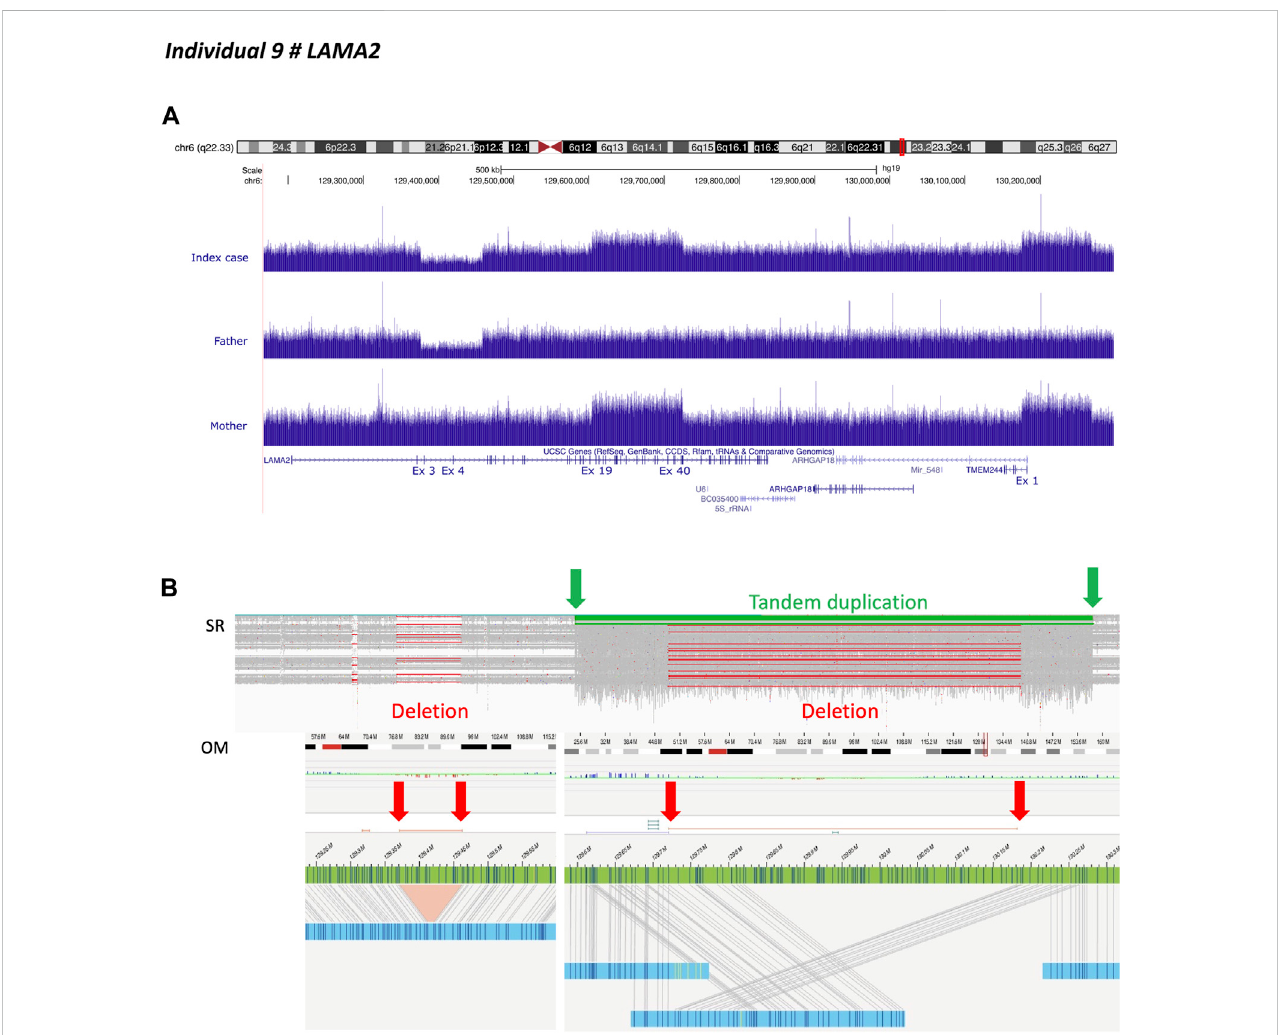
FIGURE 1 Individual 9 — Muscular dystrophy, limb-girdle, autosomal recessive 23, MIM 618138. (A) Ideogram showing chromosome 6 and LAMA2 localization. UCSC genome browser snapshot with visualization of LAMA2 sequencing depth with an intragenic deletion encompassing exons 3 and 4 inherited from heterozygousfatherandintragenicduplicationsaffectingexons19through39of LAMA2 andthe fi rstexonof TMEM244 ,inheritedfromheterozygousmother. (B) Short-read sequencing and optical genomic mapping (OM) results demonstrated that LAMA2 and TMEM244 duplications belonged to the same complex event, including a partial deletion of the intergenic region within the duplicated fragment (i.e. copy neutral region). The insertion breakpoint is indicated by the green arrow on the